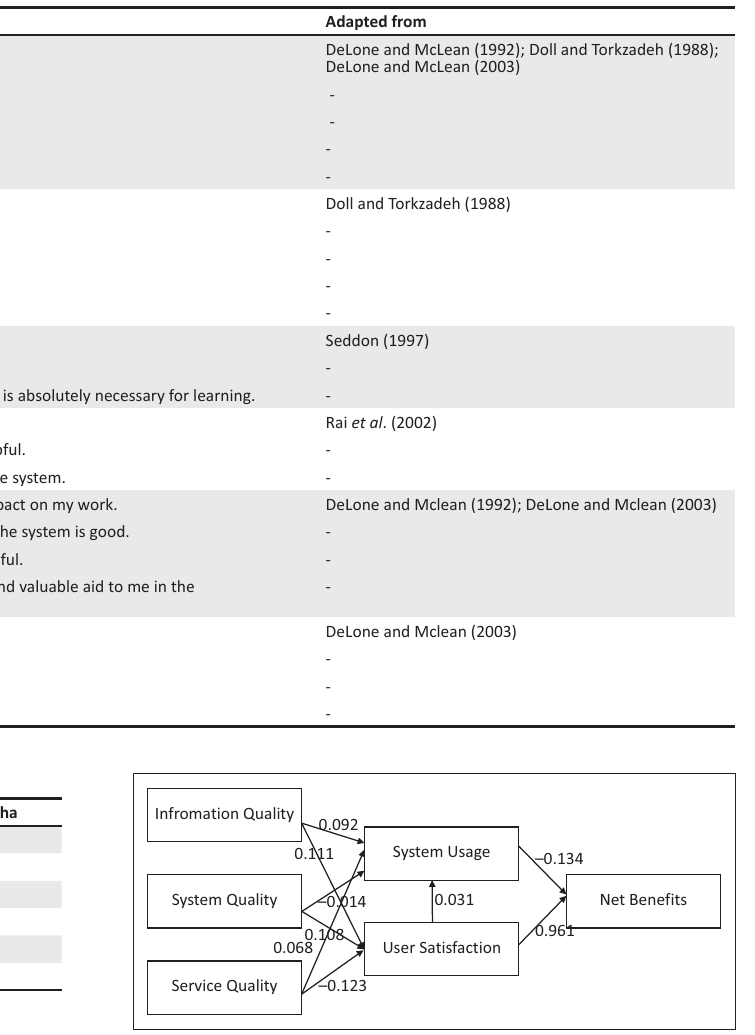
FIGURE 2: Structural model test